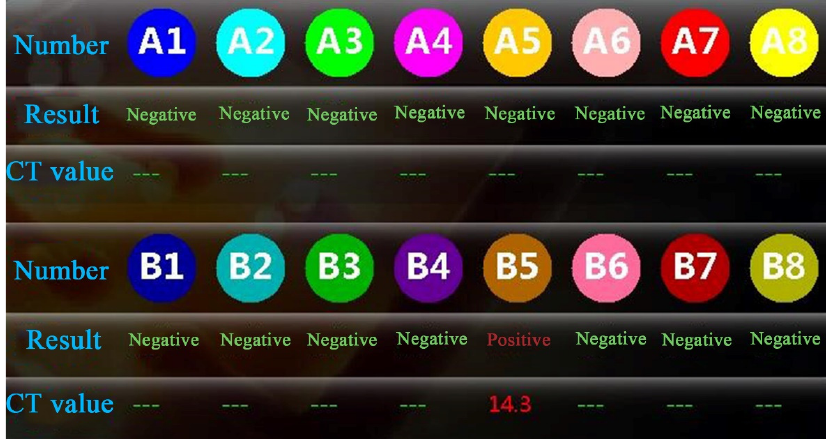
Figure 5. The results of detection of different nematodes by EMA.A1–A8 and B1–B6 are the well numbers, and the corresponding test samples of wells A1–A8 are Bm01–Bm08. The corresponding test samples of wells B1–B4 are Bm09, Bm10, Bs01 and Bv01, respectively; well B5 is the positive control, and well B6 is the negative control. B7 and B8 are empty slots.